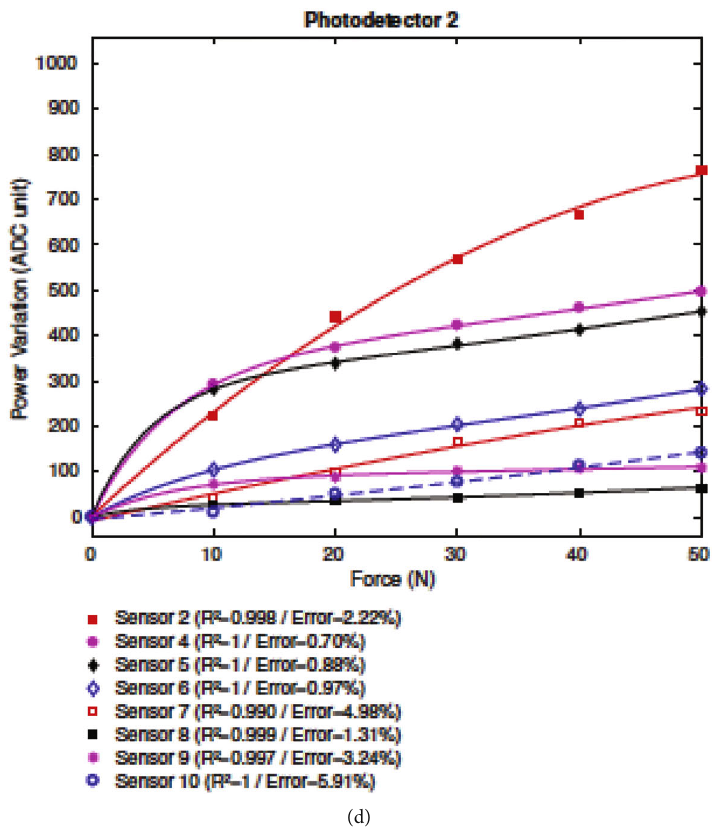
Figure 3: Force characterization response: (a) right POFS 1 and 2 with P1; (b) left POFS 1 and 3 with P2; (c) right POFS 3 – 10 with P1; (d) left POFS 2 and 4 – 10 with